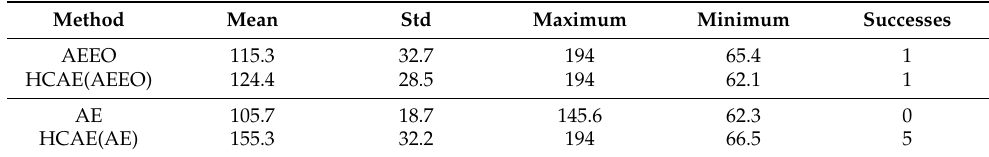
Table 2. Results of the first phase of experiments—TSP.